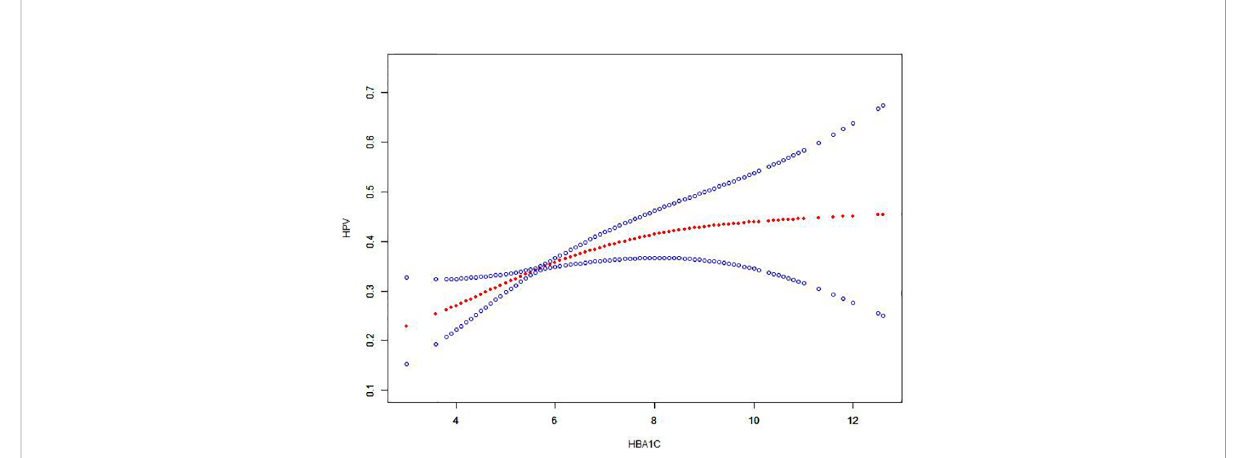
FIGURE 1 The association between HbA1c and HPV. Note: The red line represents the fi tted curve of HbA1c and HPV, and the blue line represents the 95% con fi dence interval of the curve.